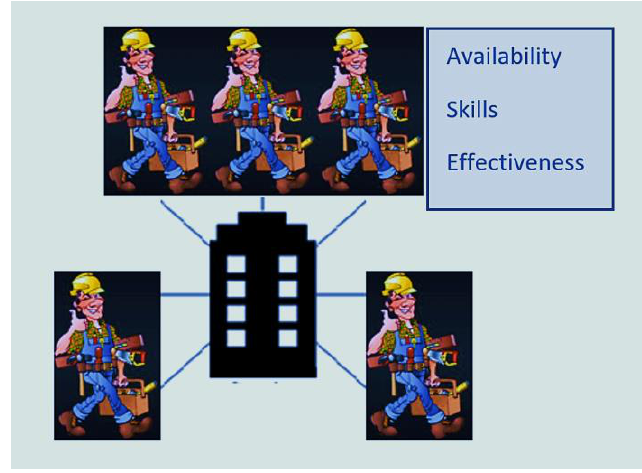
Figure 3. Service center.